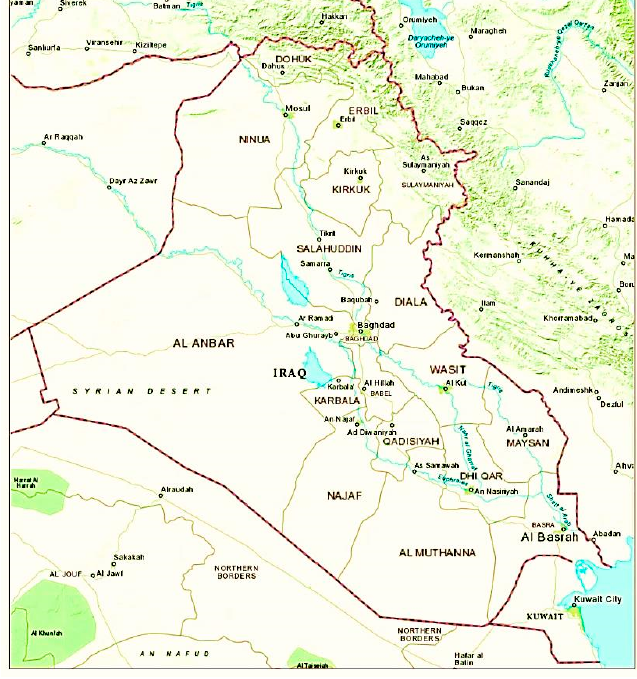
Figure 1. Map of Iraq and its provinces (the study area).